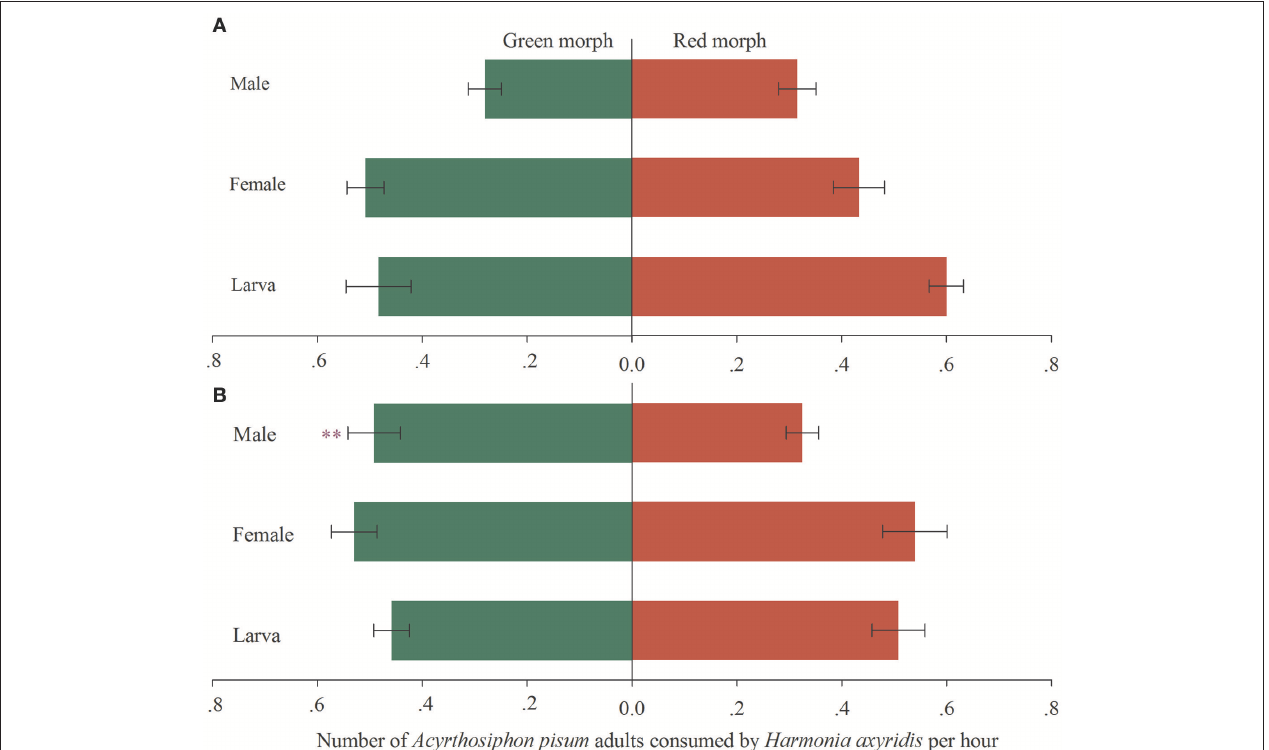
FIGURE 1 | Preference of H. axyridis on two morphs of A. pisum . Green areas represent the predation on the green morph, while red areas represent the predation on the red morph. Asterisk indicates a significant difference between the average number of the red and the green morphs consumed by H. axyridis ( p < 0.05). (A) Red